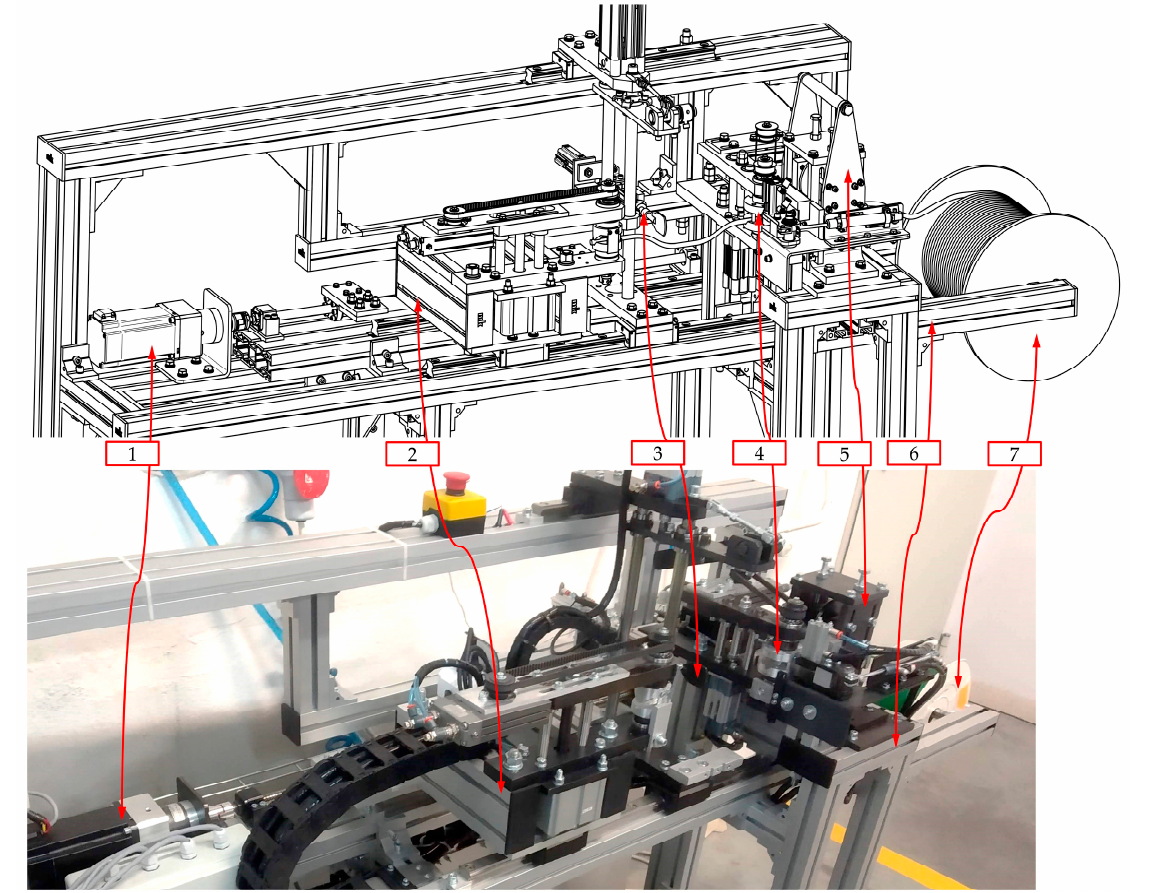
Figure 4. The prototype of the automatic welding machine: 1—the main drive unit of the device, 2—movable belt holder assembly, 3—heating unit, 4—fixed belt holder assembly, 5—roller feeder assembly with cutting unit, 6—frame, 7—spool with the belt wounded.